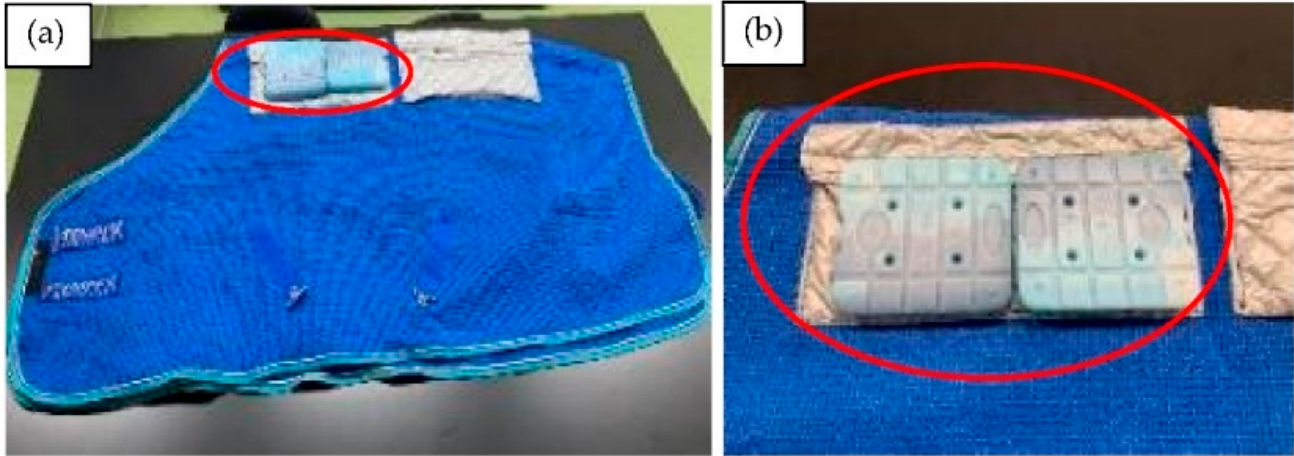
Figure 1. The ice horse blanket consisted of a thin horse blanket, four bags, and 8 ice packs. ( a ) One side of an ice horse blanket is shown. ( b ) Each cold-sheet bag could contain two ice